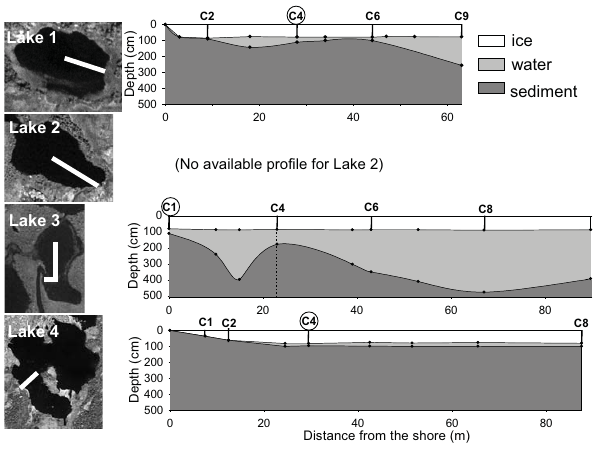
Fig. 2. Lakes geometry along the profiles and ice core sampling lo- cations. The white line on lakes shows the transect direction, letters and numbers correspond to the cores studied for the bubbles mor- phology and circles indicate cores analyzed for their gas properties. The dotted line in the lake 3 profile shows the change of azimuth of the